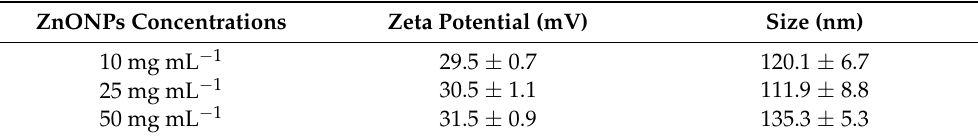
Figure 2. The UV–Vis spectra of reaction mixture containing stabilized biogenic zinc oxide nanoparti- cles (ZnONPs). Table 1. Zeta potential (mV) and size of three different concentration of biogenic ZnONP suspensions in